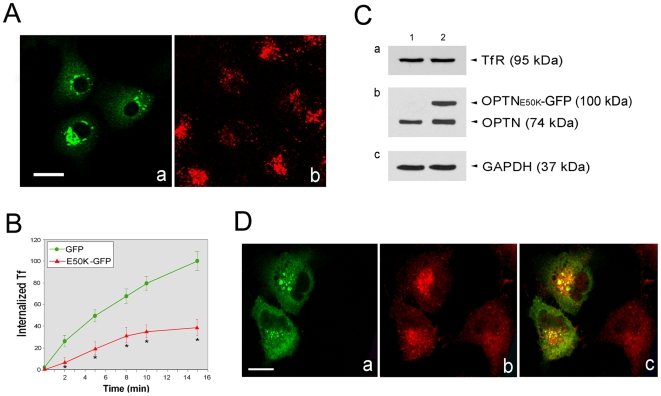
Effects of OPTNE50K-GFP expression on Tf uptake, total TfR level, and TfR distribution in RPE cells.(A) Fluorescent images of RPE cells transfected with pOPTNE50K-GFP for 16 h and incubated with TR-Tf for 15 min. The transfected cells are in green (Aa) and the internalized TR-Tf is seen in red (Ab). Scale bar, 20 µm. (B) Quantification of TR-Tf uptake in GFP (green filled circles)- and OPTNE50K-GFP (red triangles)-expressing cells. Fluorescence intensity of TR-Tf in the cells was measured at various time points. *, P<0.0001 compared to GFP controls. (C) Lysates (50 µg total protein) from RPE cells transfected with pEGFP-N1 (lane 1) or pOPTNE50K-GFP (lane 2) were immunoblotted with anti-TfR (Ca), anti-optineurin (OPTN) (Cb), and anti-GAPDH (Cc) antibodies. The expression level of 95-kDa TfR was similar in lanes 1 and 2. A 74-kDa endogenous optineurin band and a 100-kDa OPTNE50K-GFP band were detected. The GAPDH level was used to control protein loading. (D) RPE cells transfected with pOPTNE50K-GFP (Da, green) were immunostained with anti-TfR (Db, red). Merged image (Dc) shows colocalization between OPTNE50K-GFP and TfR in yellow.